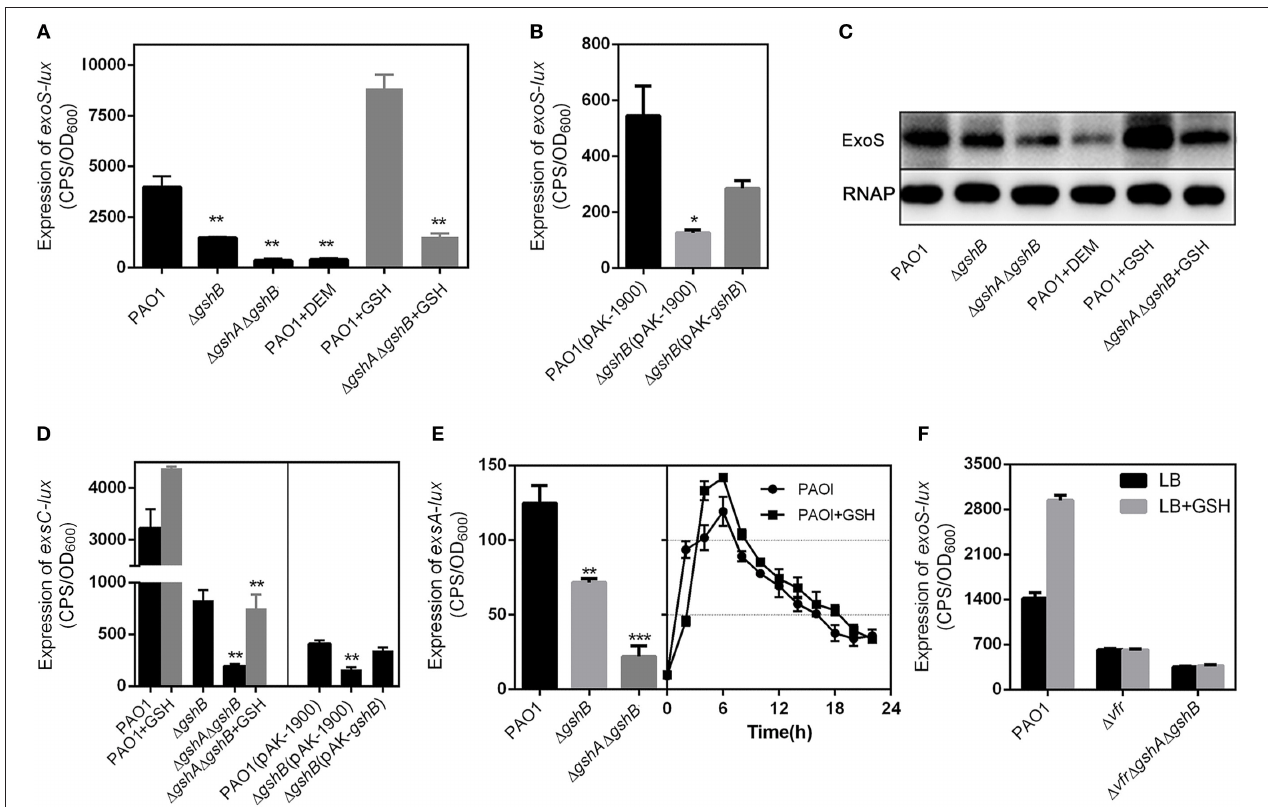
FIGURE 3 | GSH upregulates the expression of T3SS genes through Vfr. All P. aeruginosa strains carrying plasmids, exoS - lux , P exsC -lux , and P exsA -lux were grown under T3SS inducing conditions (5mM EGTA, 20mM MgCl 2 ) with or without GSH. The results shown are mean ± SEM. (A) The expression of exoS in the indicated lux reporter strains. (B) The expression of exo S in the genetically-complemented 1 gshB strain. (C) ExoS level in the indicated P. aeruginosa strains. Overnight bacterial cultures were subcultured in fresh media with or without 10mM GSH for 3h. Whole-cell extracts were resolved by SDS-PAGE and subjected to Western blotting. (D) The expression of P exsC in PAO1, 1 gshB, 1 gshAgshB and genetically-complemented 1 gshB strains in the presence or absence of 10mM GSH. (E) The expression of P exsA in PAO1, 1 gshB and 1 gshA 1 gshB . (F) The expression of exoS was induced by GSH in 1 vfr and 1 vfr 1 gshA 1 gshB . * P < 0.05, ** P < 0.01, *** P < 0.001, as determined by Student’s t -test.